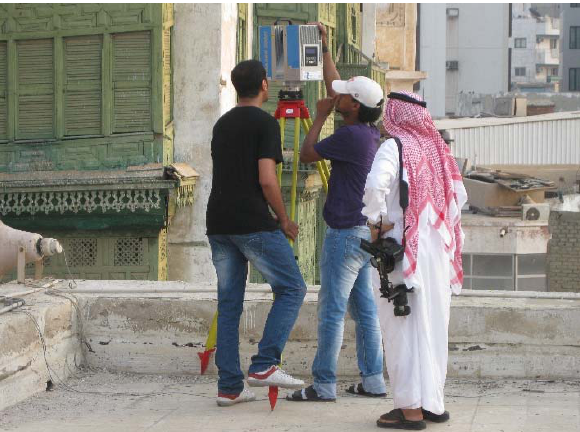
Figure 7. Scanning with Z+F Imager 5006 in Jeddah, Saudi